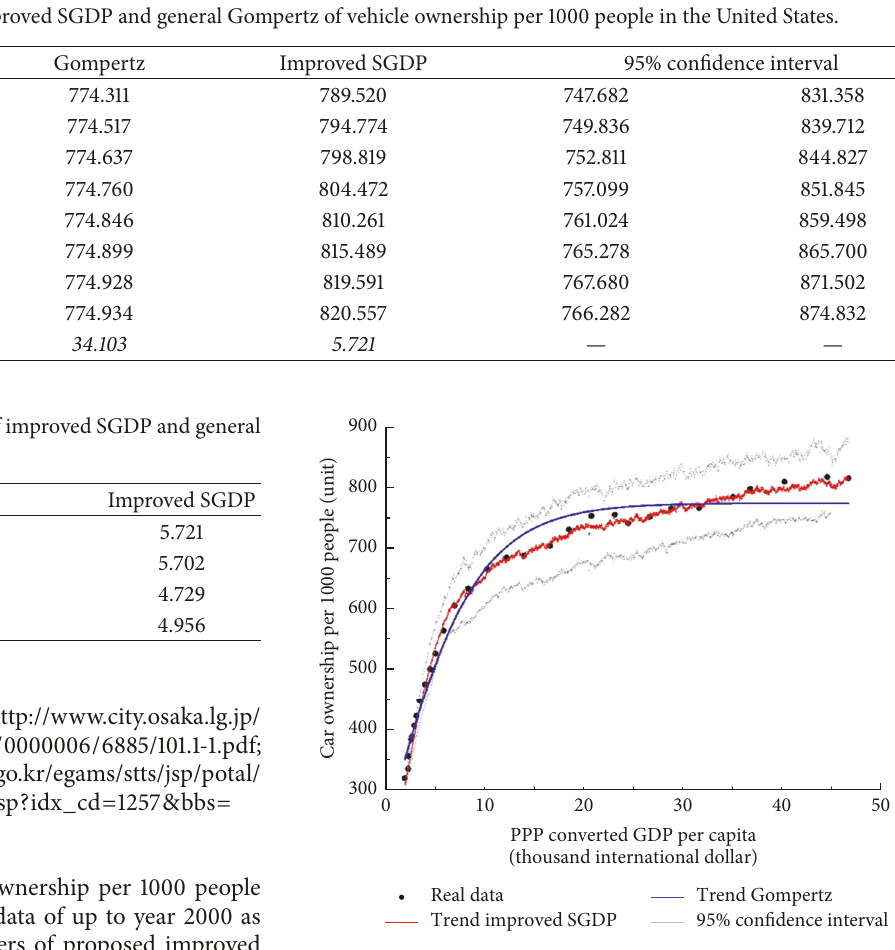
Figure 3: Real data versus Improved SDE Gompertz versus Trend Gompertz in the United